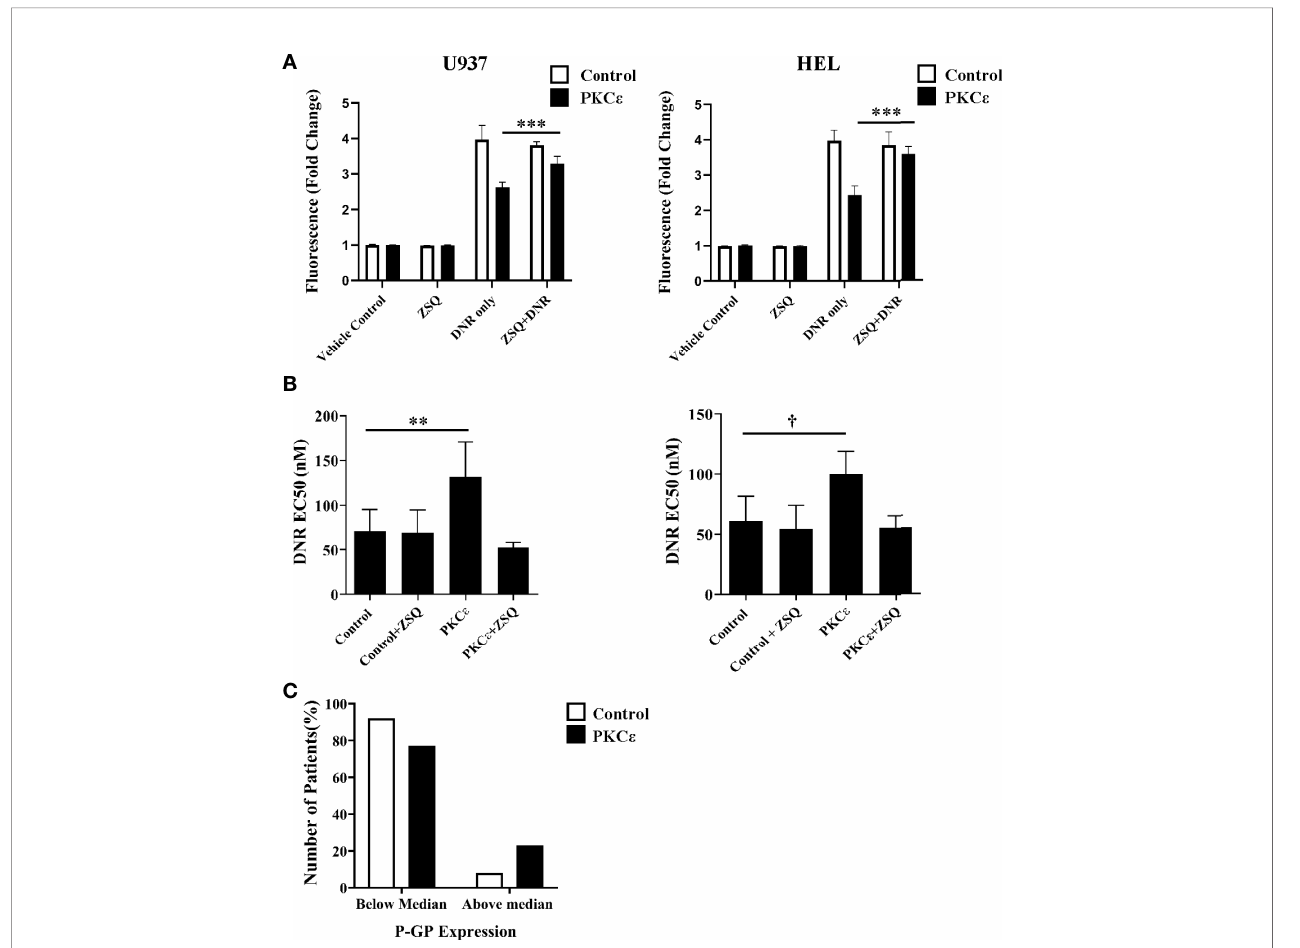
FIGURE 6 | P-GP inhibition promotes DNR accumulation and sensitization in PKC ϵ overexpression cell lines while high P-GP and PKC ϵ protein expression is observed in AML blasts. (A) Bar charts showing DNR fl uorescence (fold change relative to the fl uorescence of cells treated with the vehicle control), following 2 hours of treatment with 100nM DNR and 100nM ZSQ in U937 (left) and HEL (right) cells. DNR and ZSQ co-treatment is shown alongside the fl uorescence of cells treated with the vehicle control (PBS+0.025% ( v/v ) DMSO) or 100nM ZSQ alone (n=3), data represents mean +1SD; ***p < 0.001 using one-way ANOVA with Bonferroni post comparison test where statistical comparisons were made between the DNR alone and DNR+ZSQ treatments. No signi fi cance was observed between these treatments for the control cell lines. (B) Bar charts showing the effect of ZSQ treatment (100nM) on the EC50 (nM) of DNR, following 48 hours of treatment in U937 (left) and HEL (right) cells. Viability was determined by fl ow cytometry using TOPRO-3 staining and normalized to cells treated with the vehicle control (n=3), data represents mean+1SD; **p < 0.01, † p=0.06 using one-way ANOVA with Bonferroni post-test comparison. The dose response curves for DNR alone and DNR+ZSQ treatments are available in the Supplementary Figure 13D . (C) Bar chart showing the number of patients with above or below median P-GP protein expression in AML patients overexpressing PKC ϵ at the protein level (compared to normal CD34 + blasts; n=14) or with low PKC ϵ expression (undetectable by western blot; n=12). P-GP expression was determined cytometrically using MRK16 antibody staining